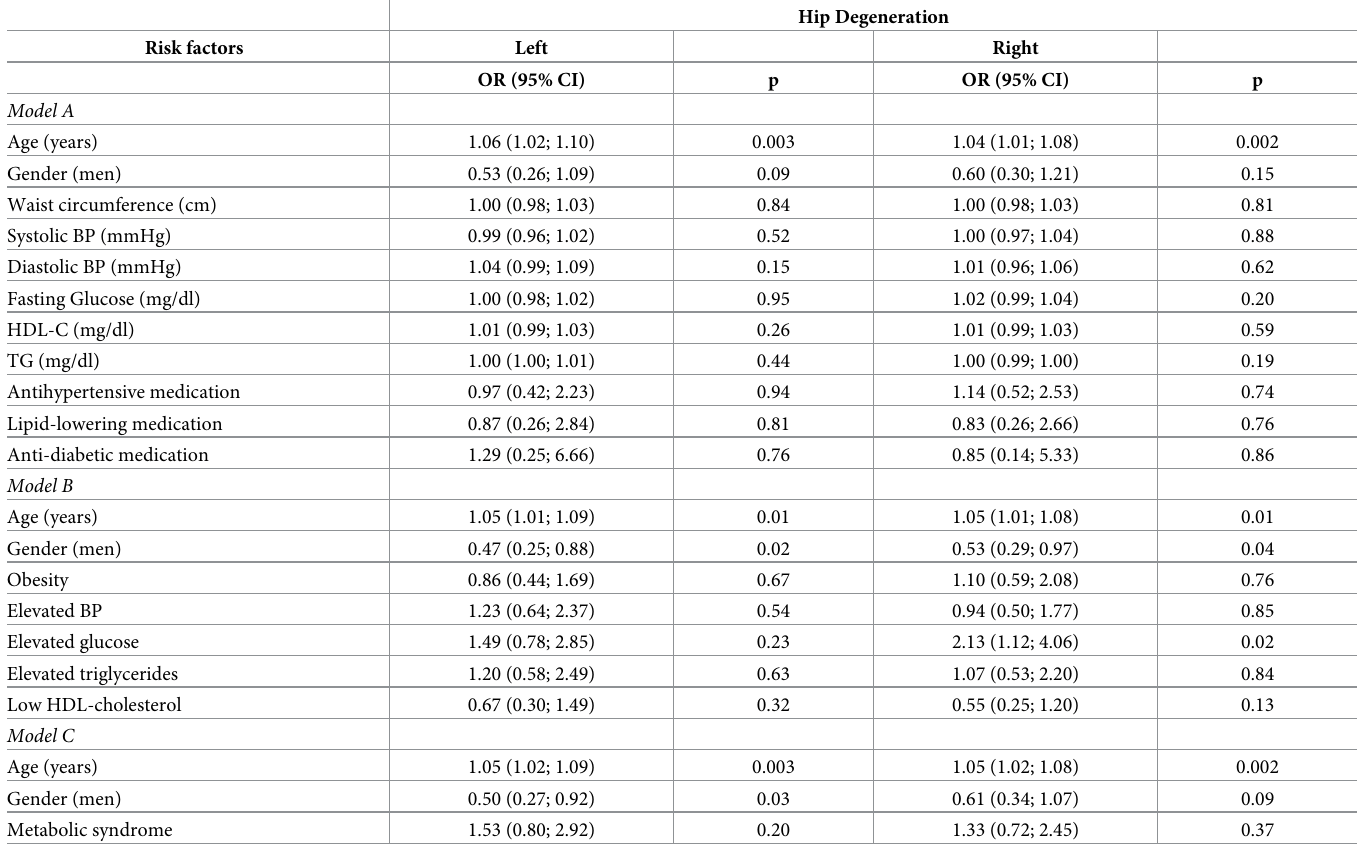
Table 3. Multivariable adjusted OR (95% CI) for associations of metabolic syndrome components with hip degeneration. Model A: Analysis of each component of the metabolic syndrome on a continuous scale. Model B: Association of the single metabolic syndrome components with osteoarthritis. Model C: Analysis of each partici- pant suffering from metabolic syndrome regardless each component.